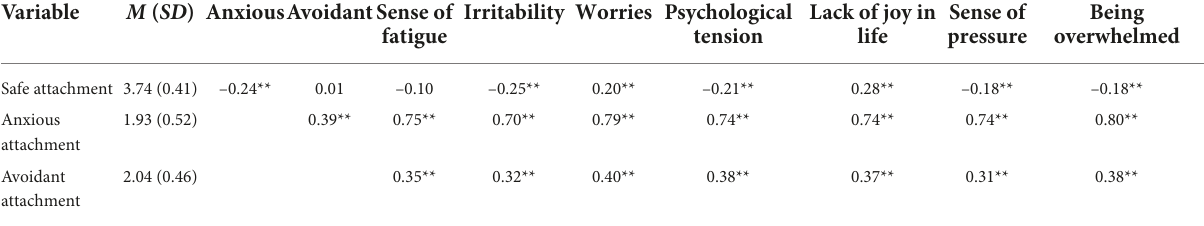
TABLE 4 Pearson’s linear correlation coefficient for the relation between maternal adult attachment and the perceived stress components.